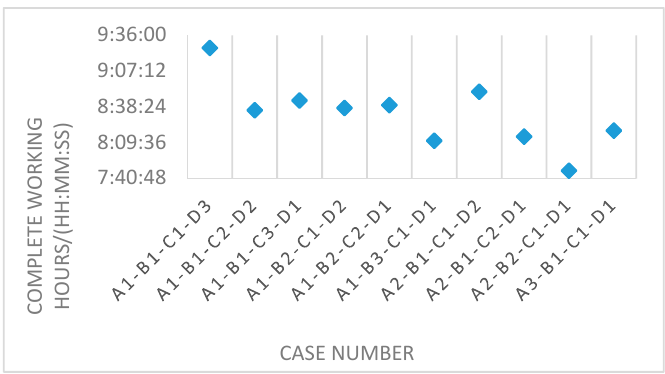
Figure 11. Completion time under 6 AGVs.